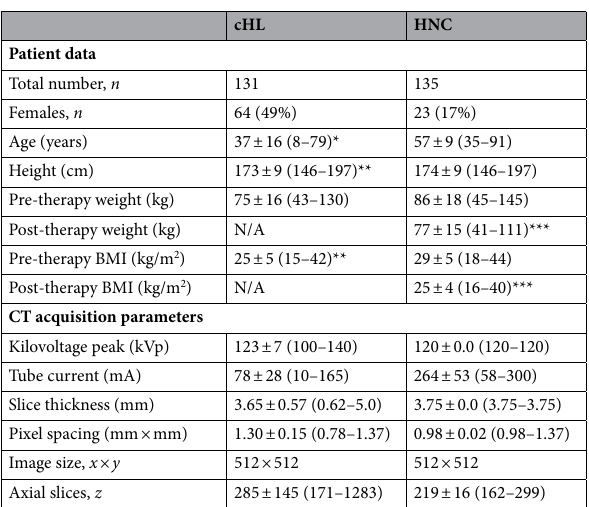
Table 1. Patient and image characteristics. Values are presented on the format mean ± standard deviation (min–max). BMI body mass index, cHL classical Hodgkin lymphoma, HNC head and neck cancer. * n = 122, ** n = 130, *** n = 134 data available only of the post-therapy